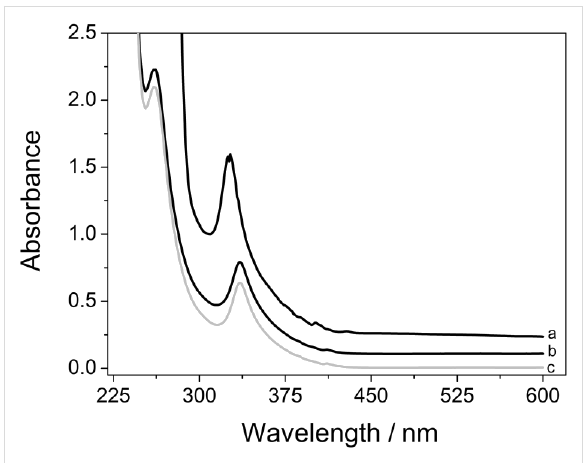
Figure 2: UV–vis spectra of (a) C 60 solution in THF, (b) aqueous solu- tions of C 60 with 6 mM γ -CD thioether 5 before centrifugation, and (c) after centrifugation (13,000 rpm) for 60 min. The absorbance inten- sities of (a) and (b) are shifted by 0.2 and 0.1 AU, respectively.